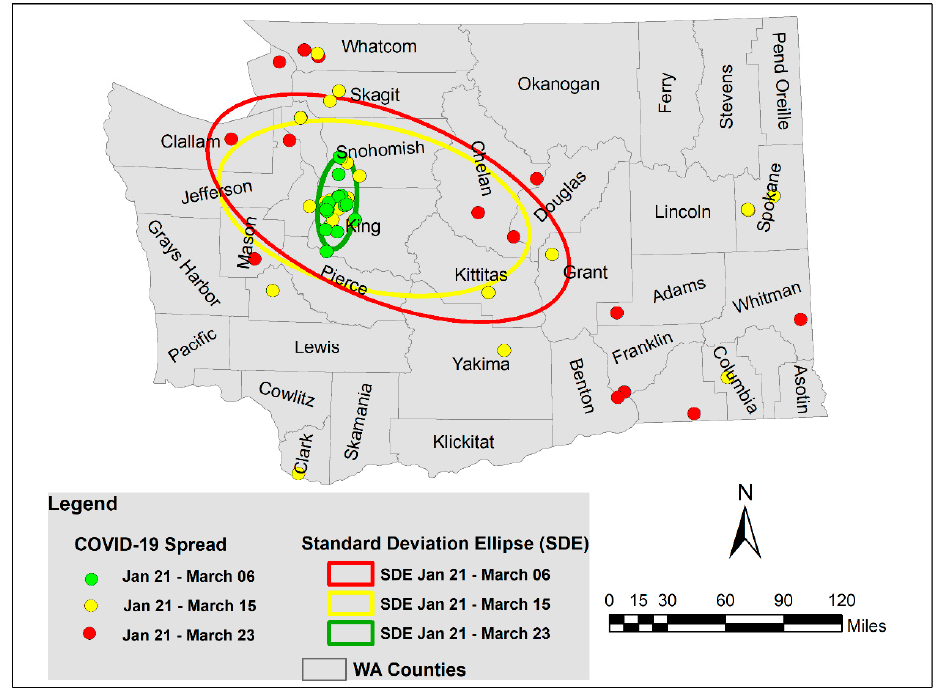
Figure 9. Spatial distribution of COVID-19 cases and the corresponding standard deviation ellipses (SDE) from 21 January to 6 March (green), 21 January to 15 March (yellow), and 21 January to 23 March (red).